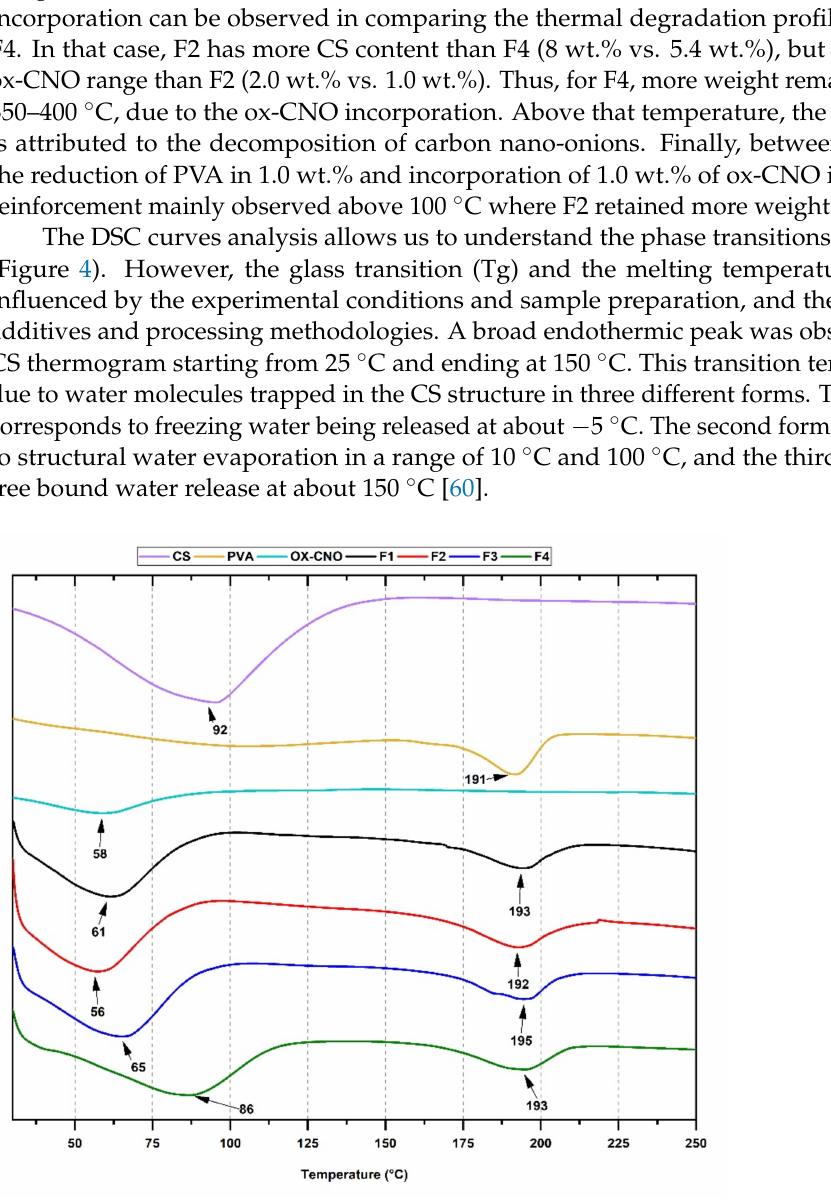
Figure 4. DSC curves of the nanofibers. Formulations: F1 (CS:PVA:ox-CNO 8:92:0); F2 (CS:PVA:ox- CNO 8:91:1); F3 (CS:PVA:ox-CNO 3.5:95.5:1); F4 (CS:PVA:ox-CNO